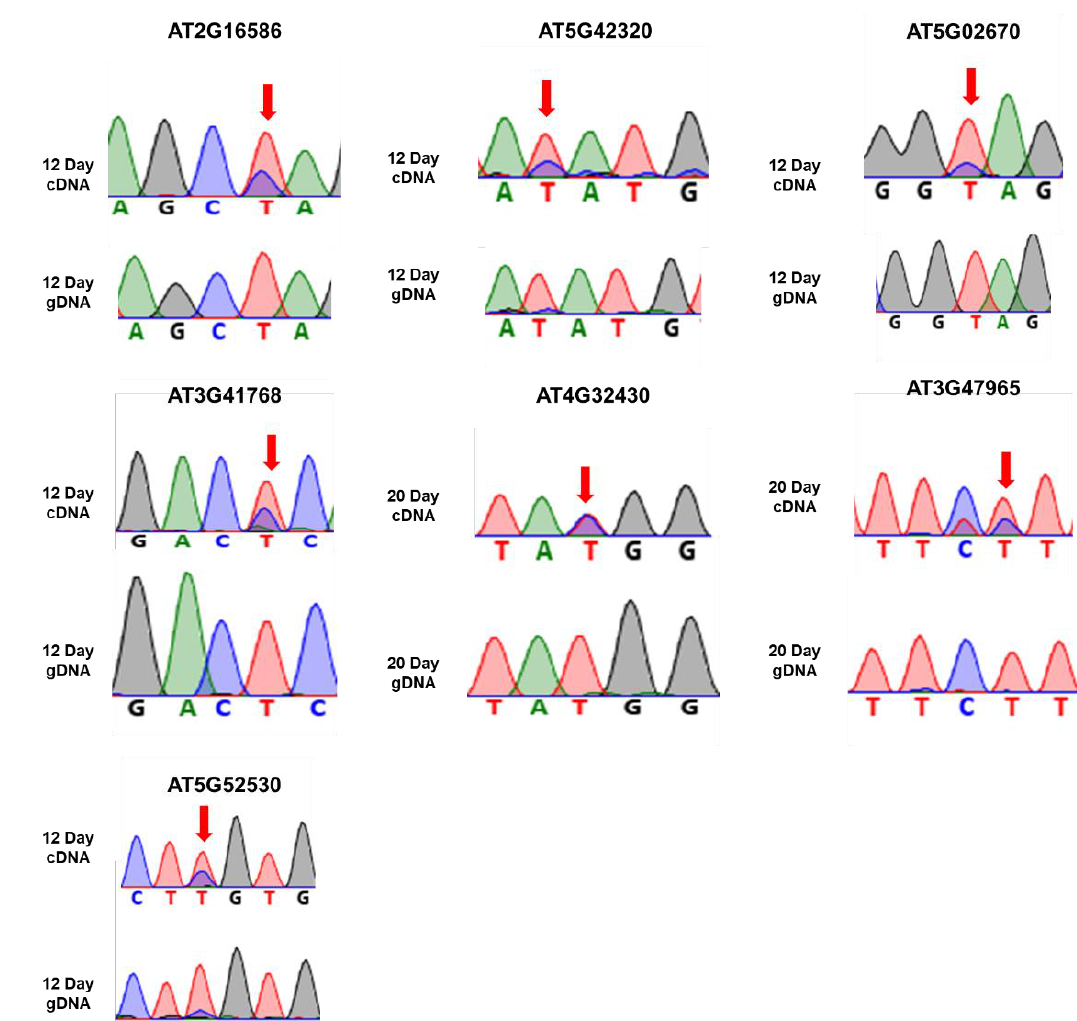
Figure 5. The Sanger sequence chromatogram depicting the U-to-C types of RNA editing events in 12-d- and 20-day-old seedlings from the same tissues of Arabidopsis via cDNA and genomic, gDNA using forward primers. Arrows indicate the position of RNA editing. Table 2. List of genes identified with U-to-C RNA editing sites in 12-day- and 20-day-old Arabidopsis seedlings.